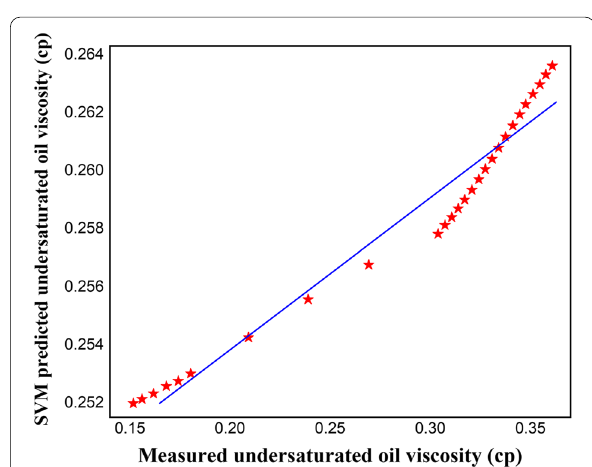
Fig. 9 Cross plot of LR predicted values versus measured